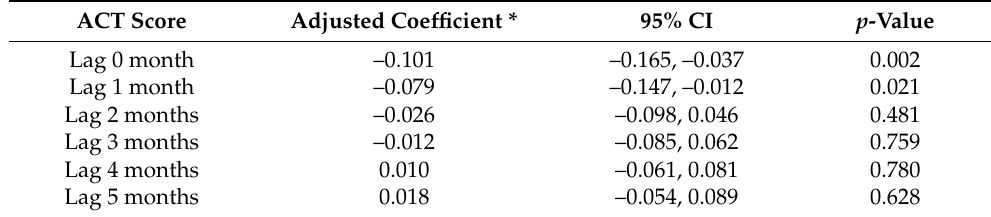
Table 6. Associations between Every 10 µ g/m 3 Increase in Monthly Average of PM 10 and Monthly Average Asthma Control Test (ACT)